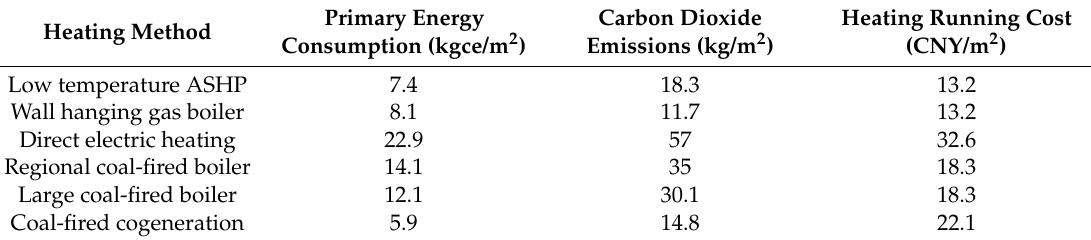
Table 1. Comparisons of primary energy consumptions, carbon dioxide emissions and heating running costs of different heating modes